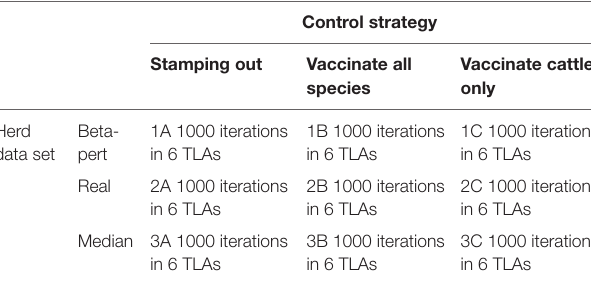
Table 4 | Tabular representation of a study designed to test the null hypothesis that uncertainty around herd size is not important when interpreting the results of a within-herd spread FMD model.